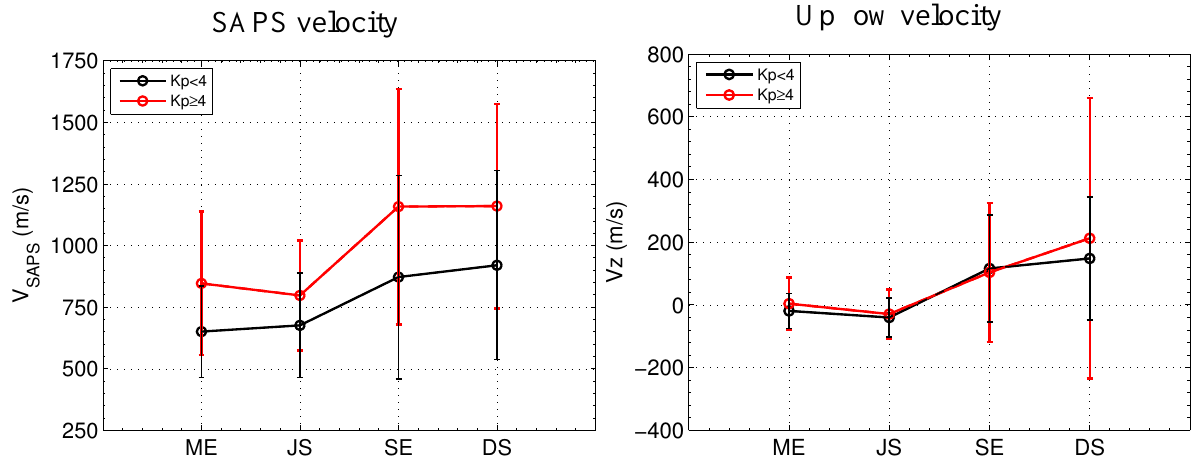
Fig. 7. Seasonal variation of the SAPS velocity (left) and upflow velocity (right) at the key MLat at 800 km altitude for Kp < 4 and Kp ≥ 4. The bars show the standard deviations of averages.